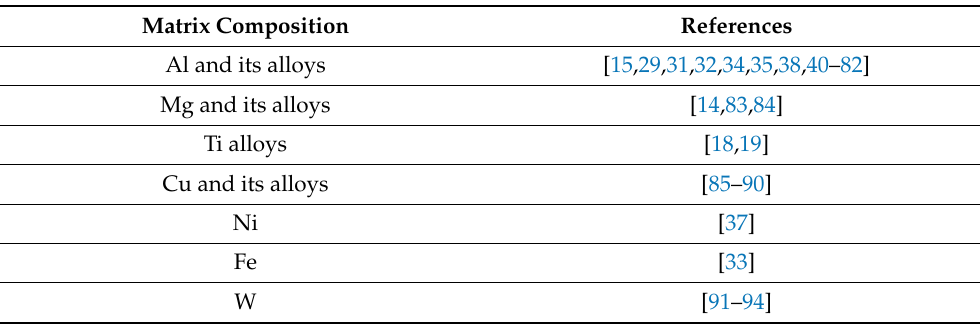
Table 2. Classification of metallic glass (amorphous alloy)-reinforced MMCs based on the main element of the